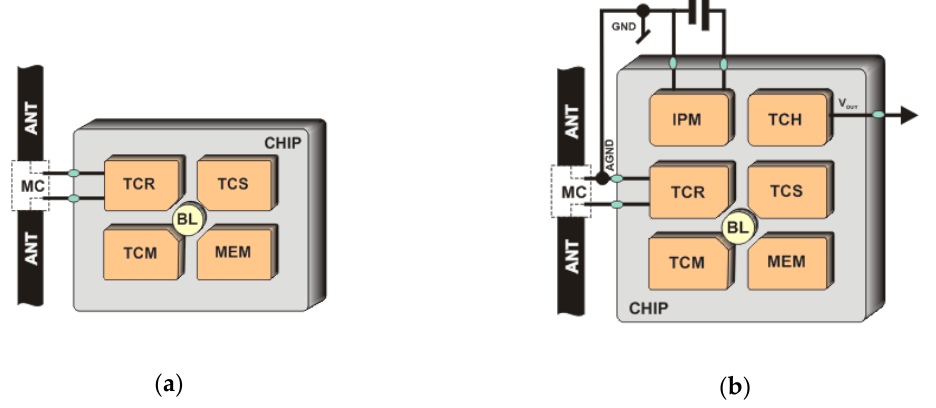
Figure 19. Connecting antenna to chip: ( a ) Passive construction; ( b ) Semi-passive construction with function of providing voltage output from internal energy harvester. GND—chip ground, AGND—antenna ground.